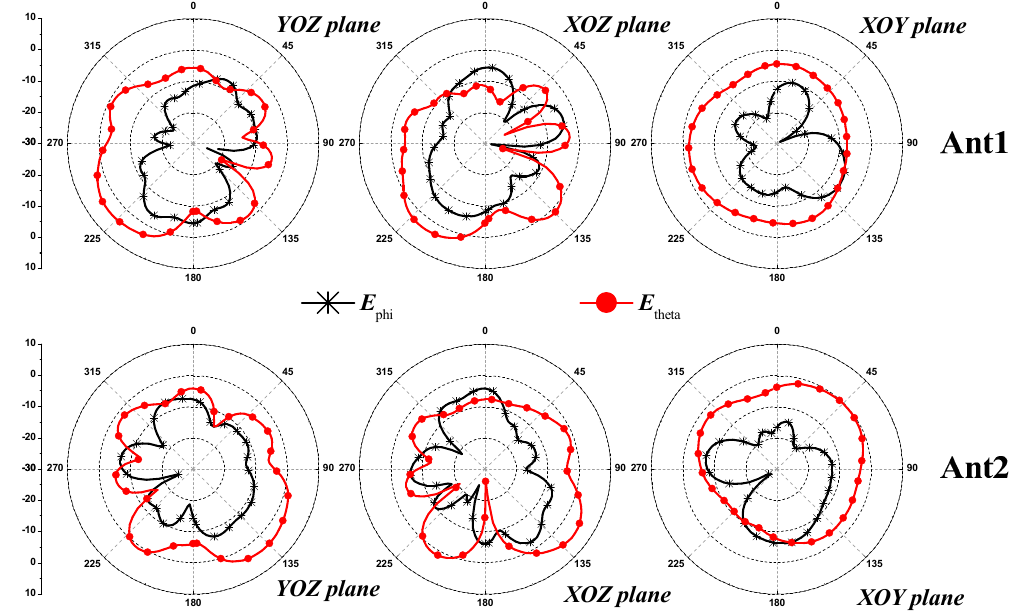
Figure 11. Measured 2 dimensional radiation patterns for Ant1 and Ant2 at 2450MHz. Table 1. Diversity performance of the proposed antenna.